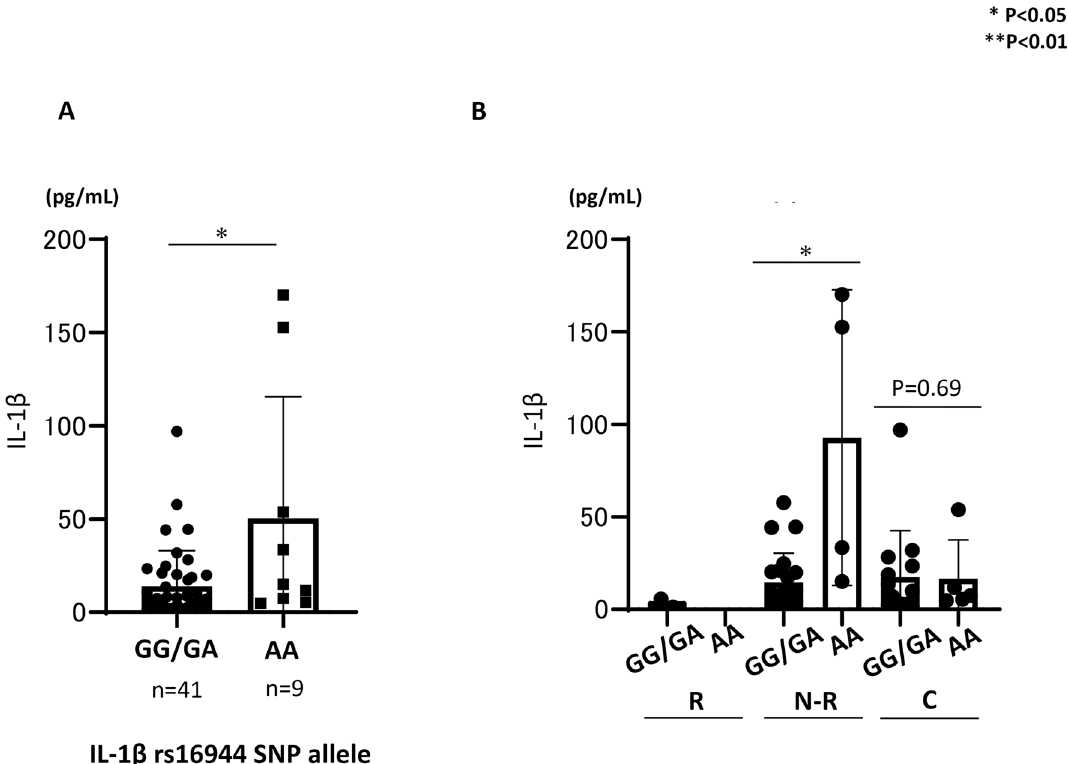
Figure 4. Comparison of IL-1β levels in HCV-infected patients treated with DAAs stratified according to the presence of the IL-1β rs16944 single nucleotide polymorphism (SNP). ( A ) Comparison of baseline IL-1β levels between HCV-infected patients with and without the IL-1β rs16944 SNP AA allele. ( B ) Comparison of baseline IL-1β levels among HCV-infected patients treated with DAAs stratified according to the presence of the IL-1β rs16944 SNP, existence of previous HBV infection, and presence of HBV reactivation during DAA therapy. HCV hepatitis C virus, HBV hepatitis B virus, DAA direct-acting antiviral, IL interleukin, R HBV reactivation, N-R non-HBV reactivation, C HCV control without previous HBV